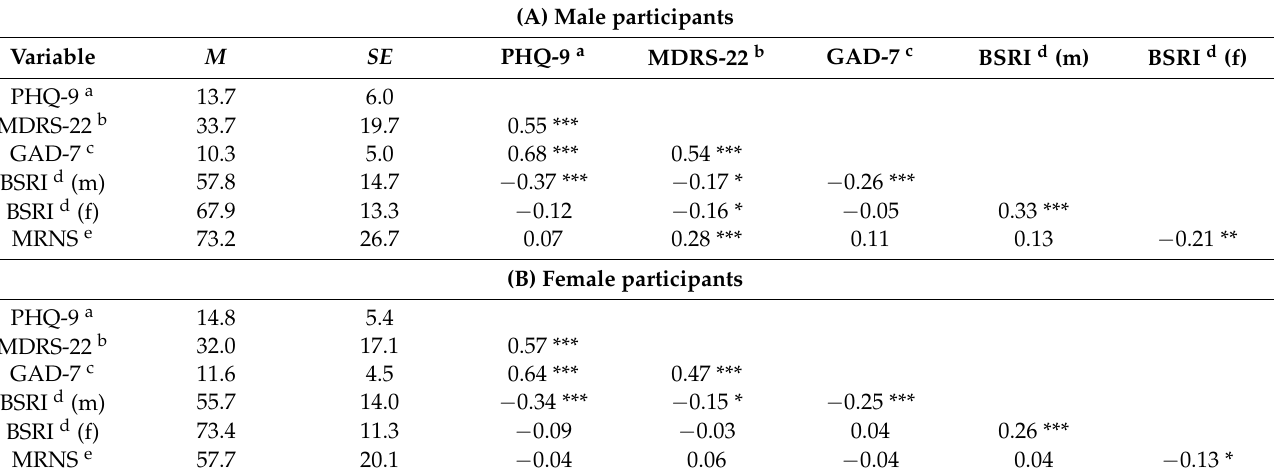
Table 2. Correlation matrices for the applied